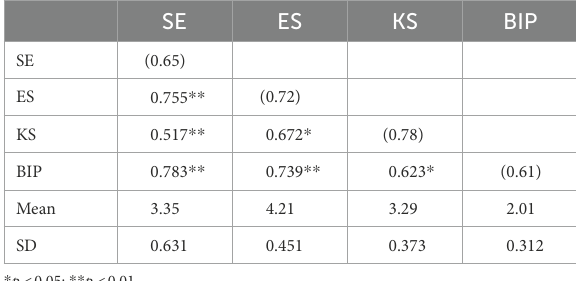
TABLE 4 Variable mean, standard deviation, correlation coefficient and mean extraction variance ( N =